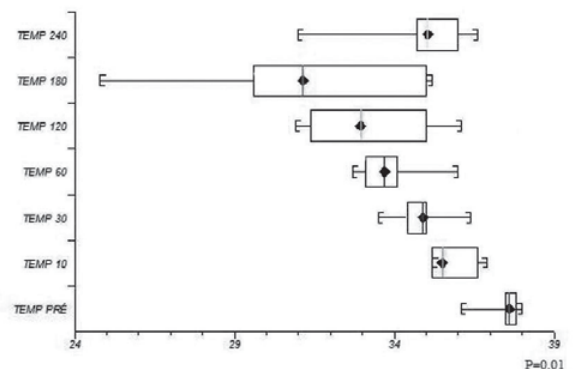
Fig. 7 – Temperatura (TEMP) prévia e no decorrer da circulação extracorpórea